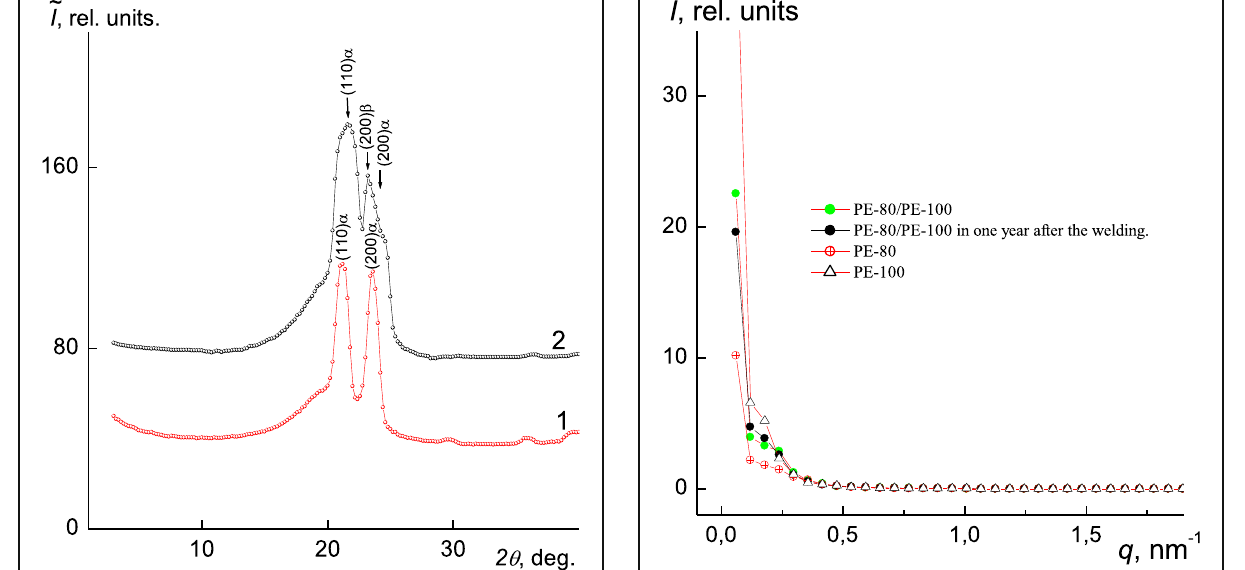
Fig. 4 WAXS diffraction patterns of PE-80/PE-100 welds, received immediately after the welding process (1) and in 1 year after the welding (2)